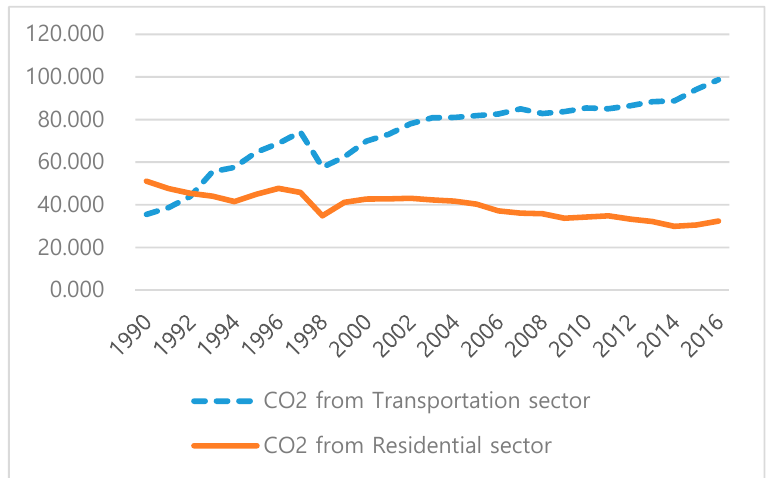
Figure 2. CO 2 Emissions from transportation and residential sector in Korea (mil. ton of CO 2 eq).